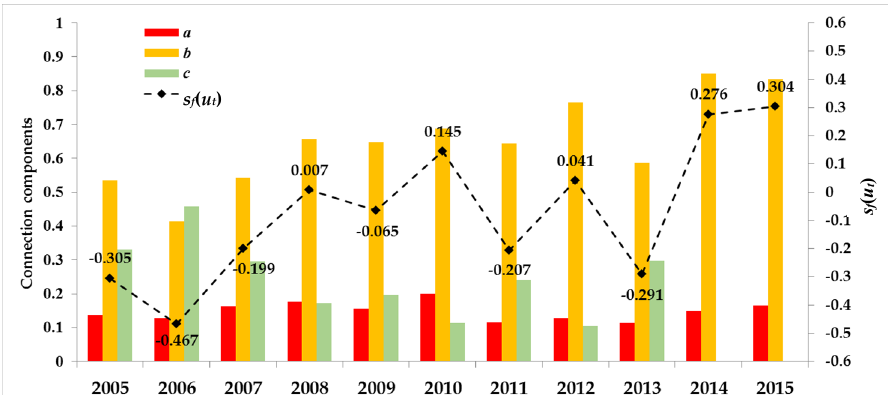
Figure 3. Connection numbers and corresponding s f (u t ) values for evaluating regional water resources carrying capacity (RWRCC) from 2005 to 2015 in Anhui Province.